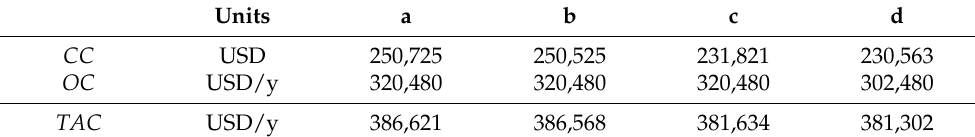
Table 5. Capital and operating costs and TAC of the retrofitted wastewater heat recovery systems.